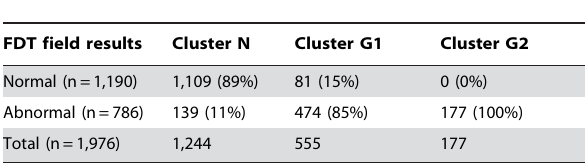
Table 1. Number of normal and abnormal FDT fields assigned to each VIM-identified cluster. Overall specificity was 0.931 and sensitivity was 0.828.